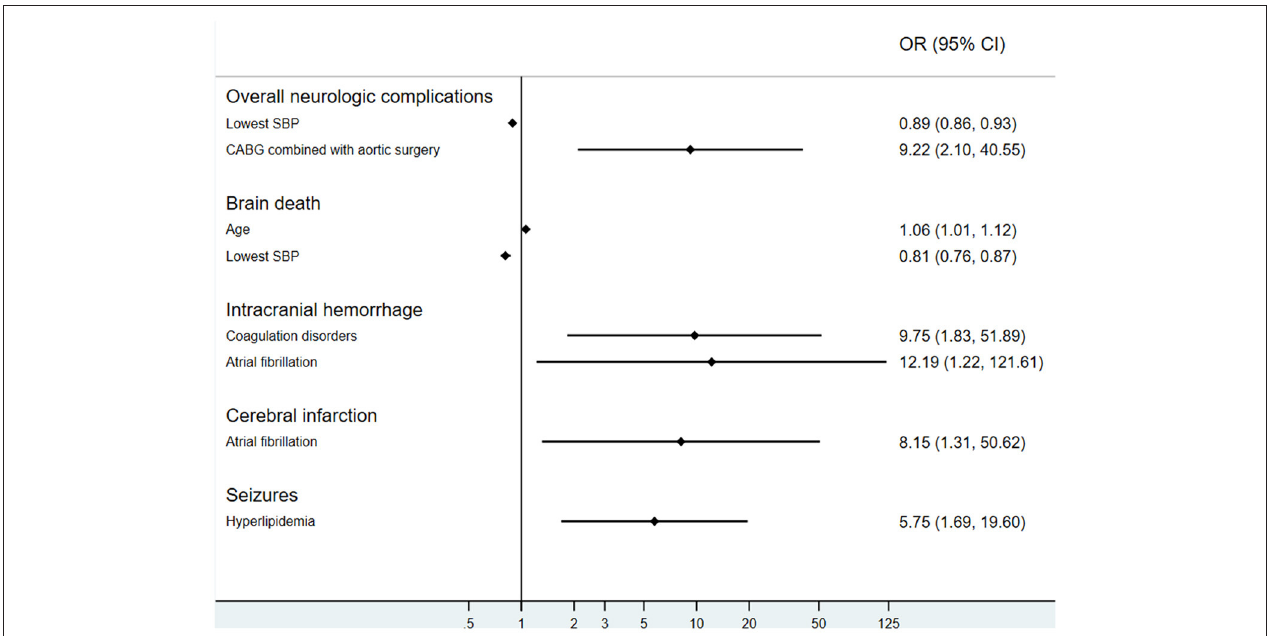
FIGURE 5 | Risk factors of neurologic complications during extracorporeal membrane oxygenation. SBP, systolic blood pressure; CABG, coronary artery bypass grafting.